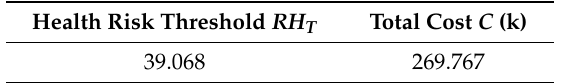
Table 3. Parameter values of the optimal predictive maintenance strategy.